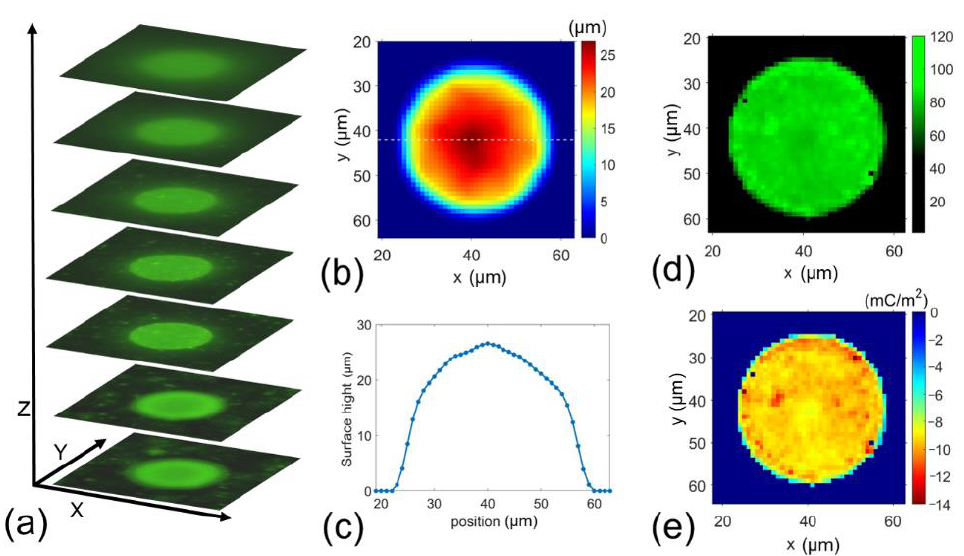
Figure 3. ( a – e ) Typical measurement results of surface charge mapping of a 31 µ m MP. ( a ) Z-stack images, ( b ) surface height mapping, ( c ) the surface height profile at the centerline located in the MP center in X-direction, ( d ) fluorescent intensity distribution, and ( e ) the surface charge mapping.